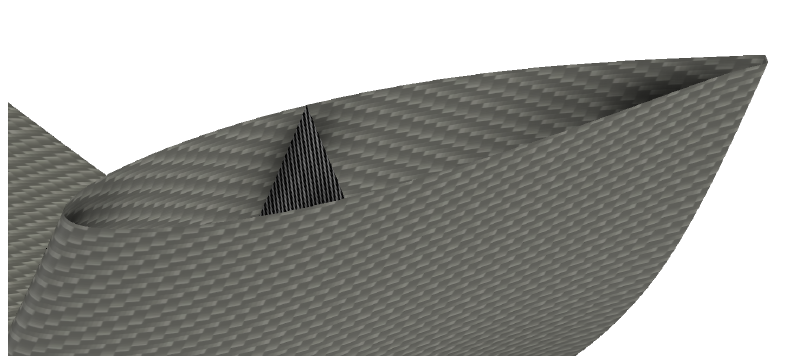
Figure 8. Estimation of the internal stiffener.